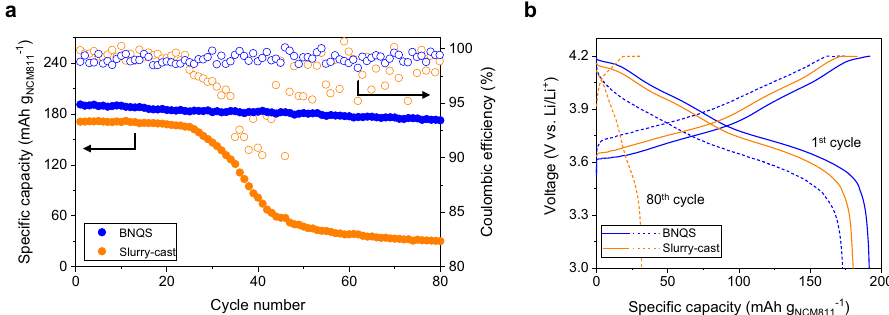
Fig. 4 Cycling performance of the BNQS cathode (versus slurry-cast cathode). a Cycling performance at charge/discharge current density of 0.05 C/0.1 C ( = 0.35 mA cm − 2 /0.7 mA cm − 2 ) and voltage range of 3.0 – 4.2 V under a limited amount of electrolyte (E/C ratio of 2.3 g Ah − 1 ), in which the coin cell containing the cathode with an areal-mass-loading of 36 mg cm − 2 . b Charge/discharge pro fi les of the cells at 1 st and 80th cycle. the same areal-mass-loading of 36 mg cm − 2 , the BNQS cathode showed the higher discharge capacities than the slurry-cast cathode over a wide range of temperatures (varying from − 10 to 60 °C) examined herein. Cycling performance of the BNQS electrode . In addition to the improved redox kinetics described above, the NCM811 || Li coin cell with the BNQS cathode showed higher capacity retention with cycling (90% after 80 cycles at a charge/discharge C rates of 0.05 C/0.1 C corresponding to 0.35 mA cm − 2 and 0.7 mA cm − 2 , NATURE COMMUNICATIONS| (2022) 13:2541